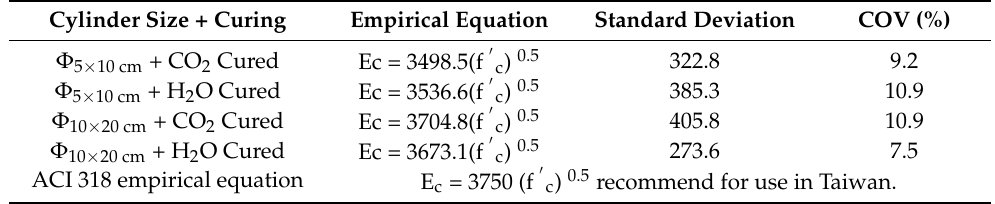
Table 6. Comparison of Ec empirical equation and statistical parameters of CO 2 cured